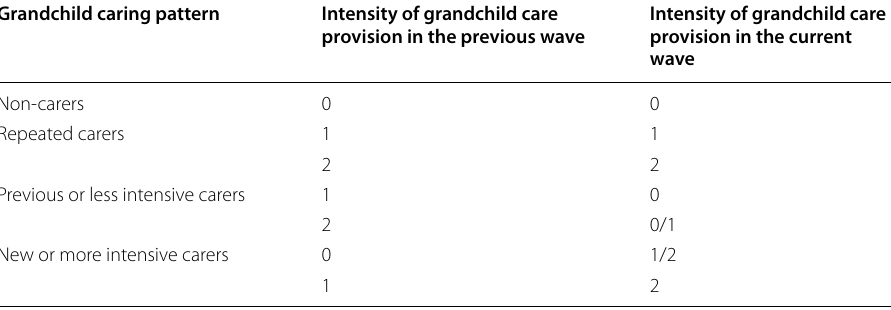
Table 1 Classification of the change in the grandchild caring intensity variable. Source: Harmonised SHARE Waves